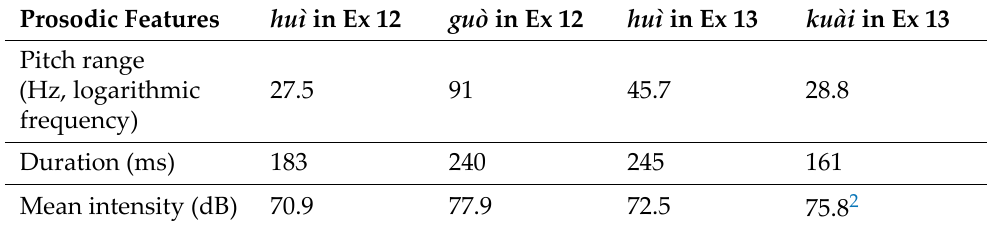
Table 1. Duration, mean intensity, and pitch range of huì in Ex 12 and Ex 13.